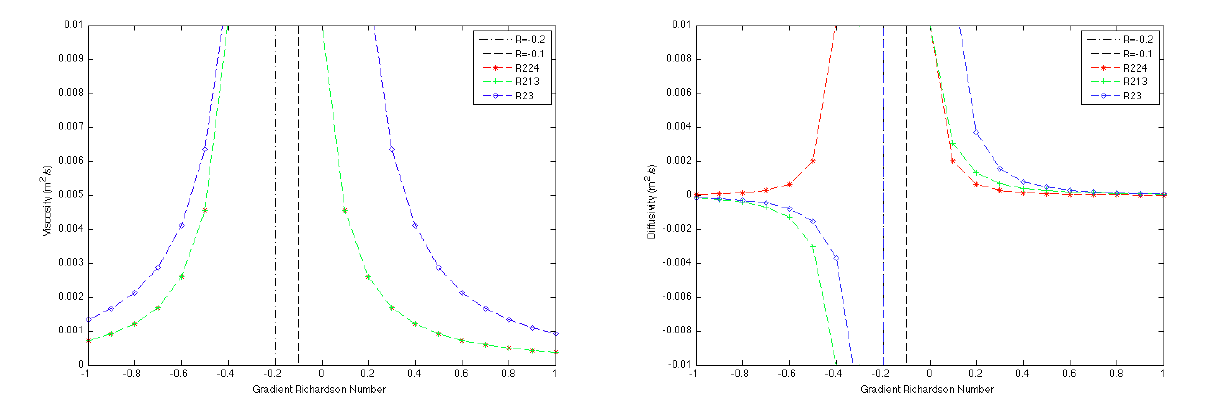
Fig. 1. Viscosity ν 1 = f 1 (R) (left) and diffusivity ν 2 = f 2 (R) (right) for models R 224, R 213 and R 23.